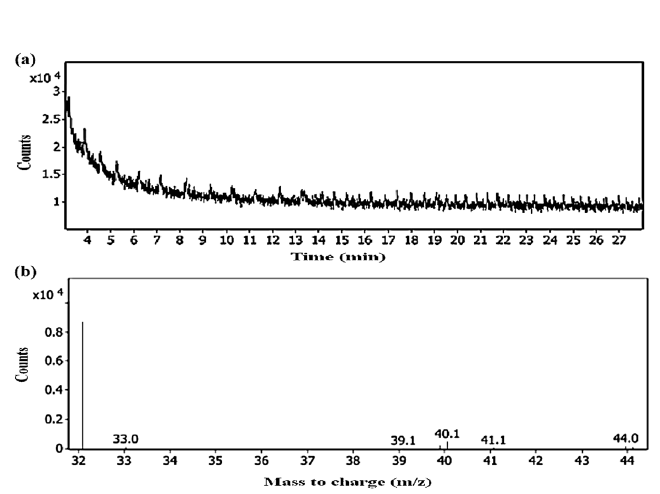
Figure 7. Gas chromatography for the solution after disinfection ( a ) scan of chlorinated compounds vs. time ( b ) mass to charge